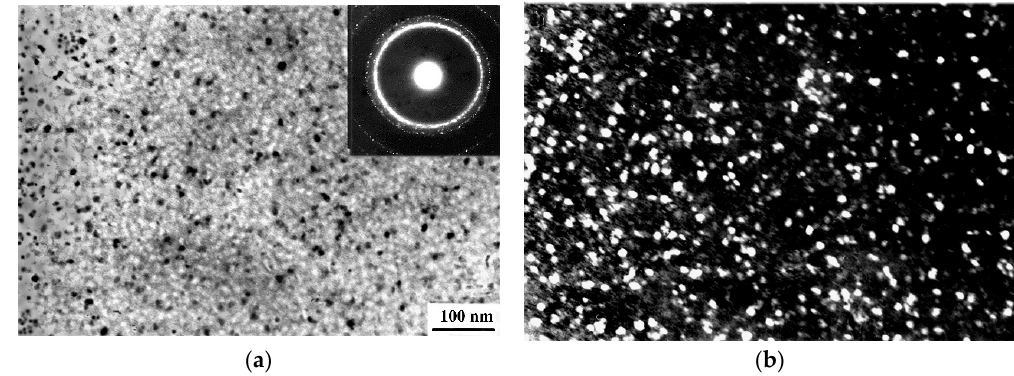
Figure 5. Microstructure of Al86Ni11Yb3 sample after annealing at 473 K for 30 min: ( a ) bright-field and ( b ) dark-field images.